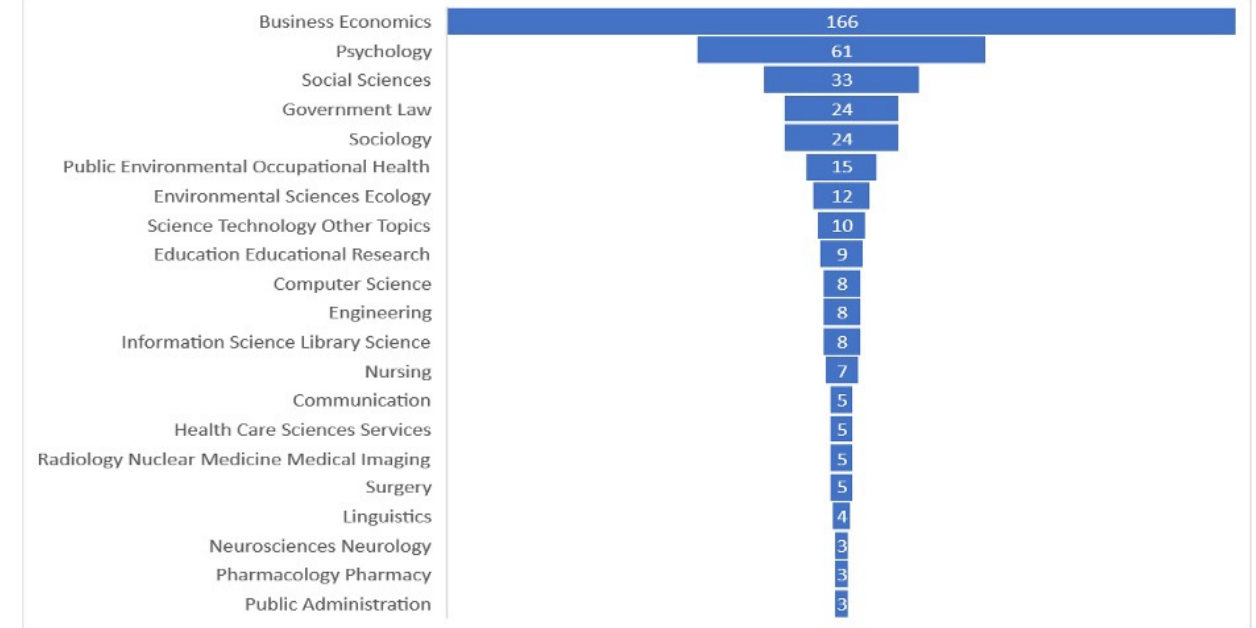
Figure 10. Most relevant thematic areas.